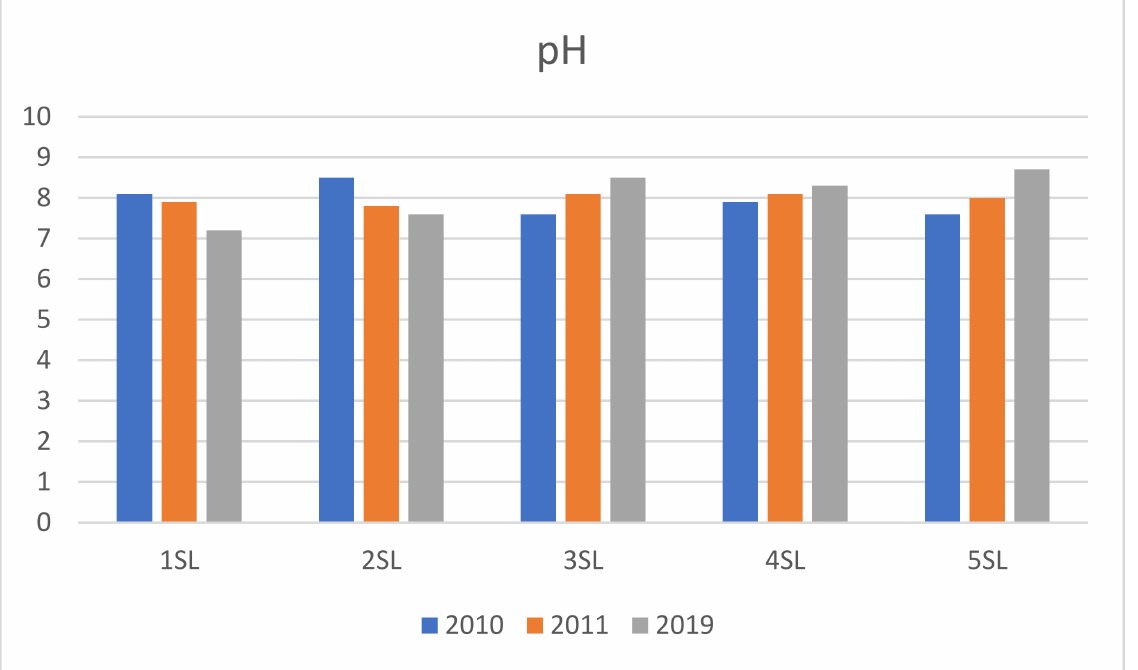
Figure 5. The measured values of pH in the water samples of the Slovinsk ý creek